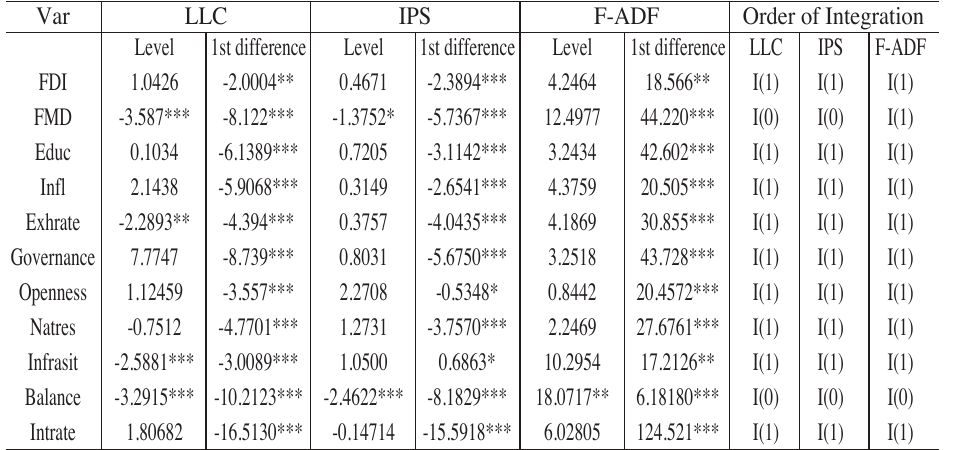
Table 1: Results of Panel Unit Root